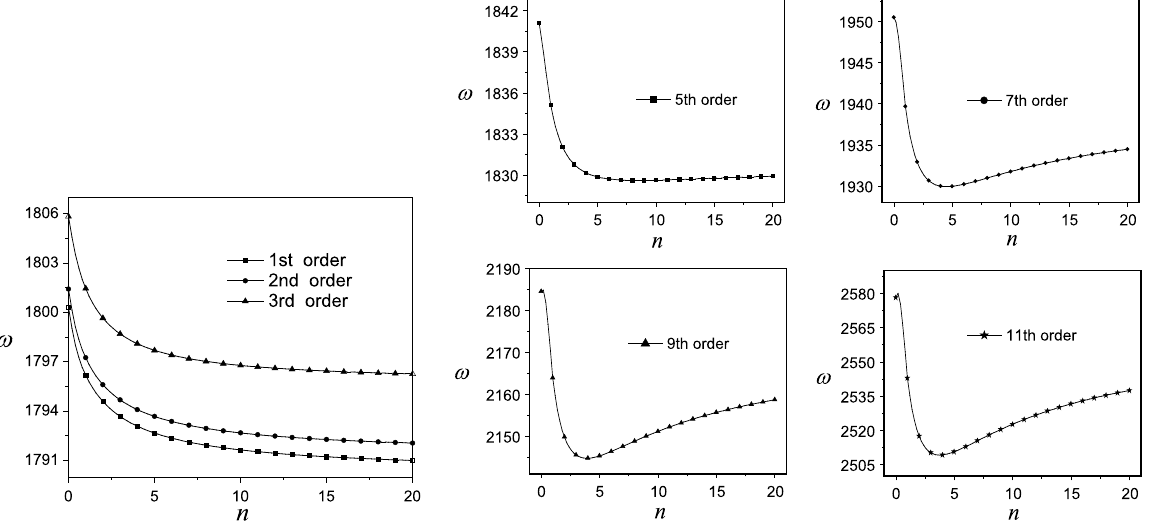
Fig. 12. The effect of volume fraction index n on the low order natural frequency ω for the simply sup- ported FGPM cylindrical shell.